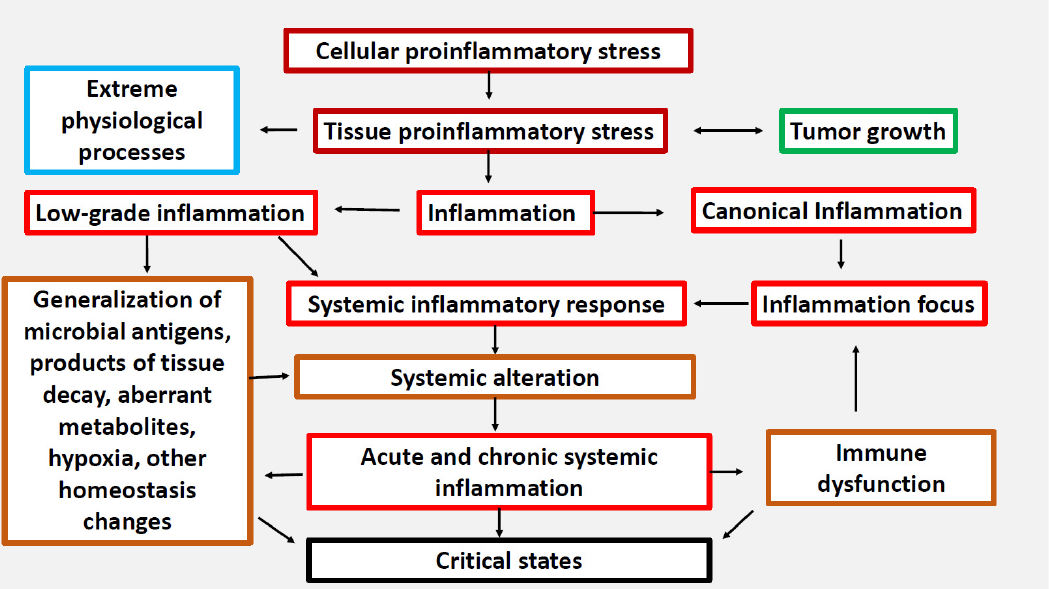
Figure 1. Relationship between cellular and tissue stress and human pathology [2]. Note. Cellular proinflammatory stress is a typical cell response to various real or potential damage of macromolecules as well as to external stressors. It is a common basis for various pathological and some physiological processes, including muscle contraction, tissue growth, mucosal function, and the exercise of normal lymphocyte selection in primary lymphoid organs. Tumor cells and tumor microenvironment cells are under stress, but tumor growth is not inflammation. Systemic hyperinflammation is a dysfunctional process, a complication of other pathological processes that initiate systemic alteration.